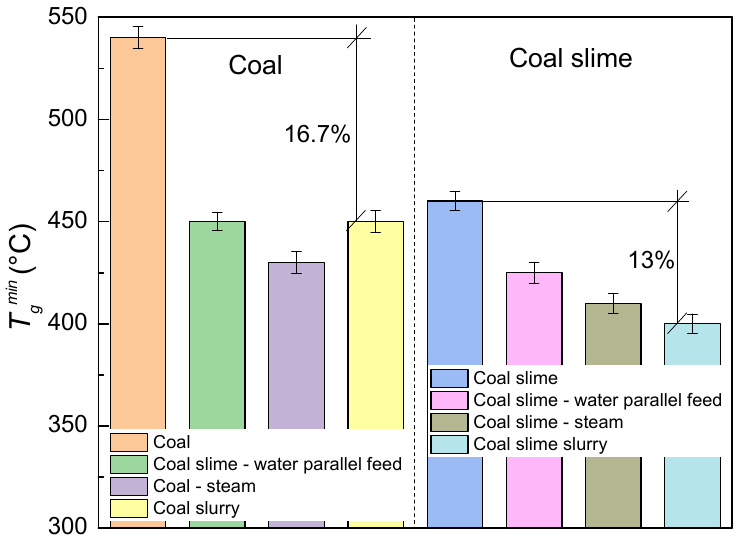
Figure 6. Minimum ignition temperatures of fuels based on bituminous coal and coal slime when varying the method of introducing the components into the combustion chamber.